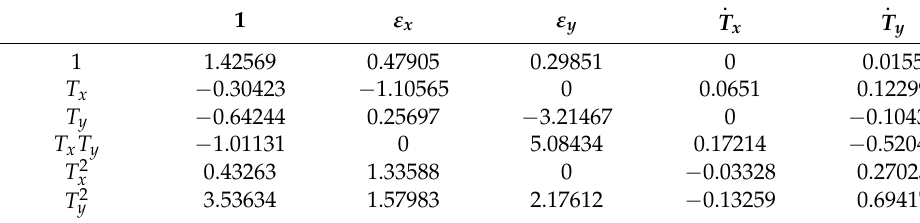
Table 6. Fitting results for (cid:101) K ty , ty .